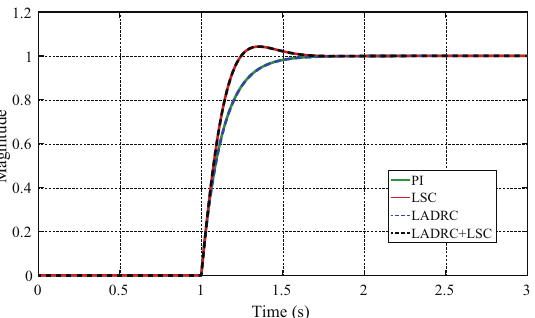
Figure 10. Unit step response with controllers of similar time-domain specifications.